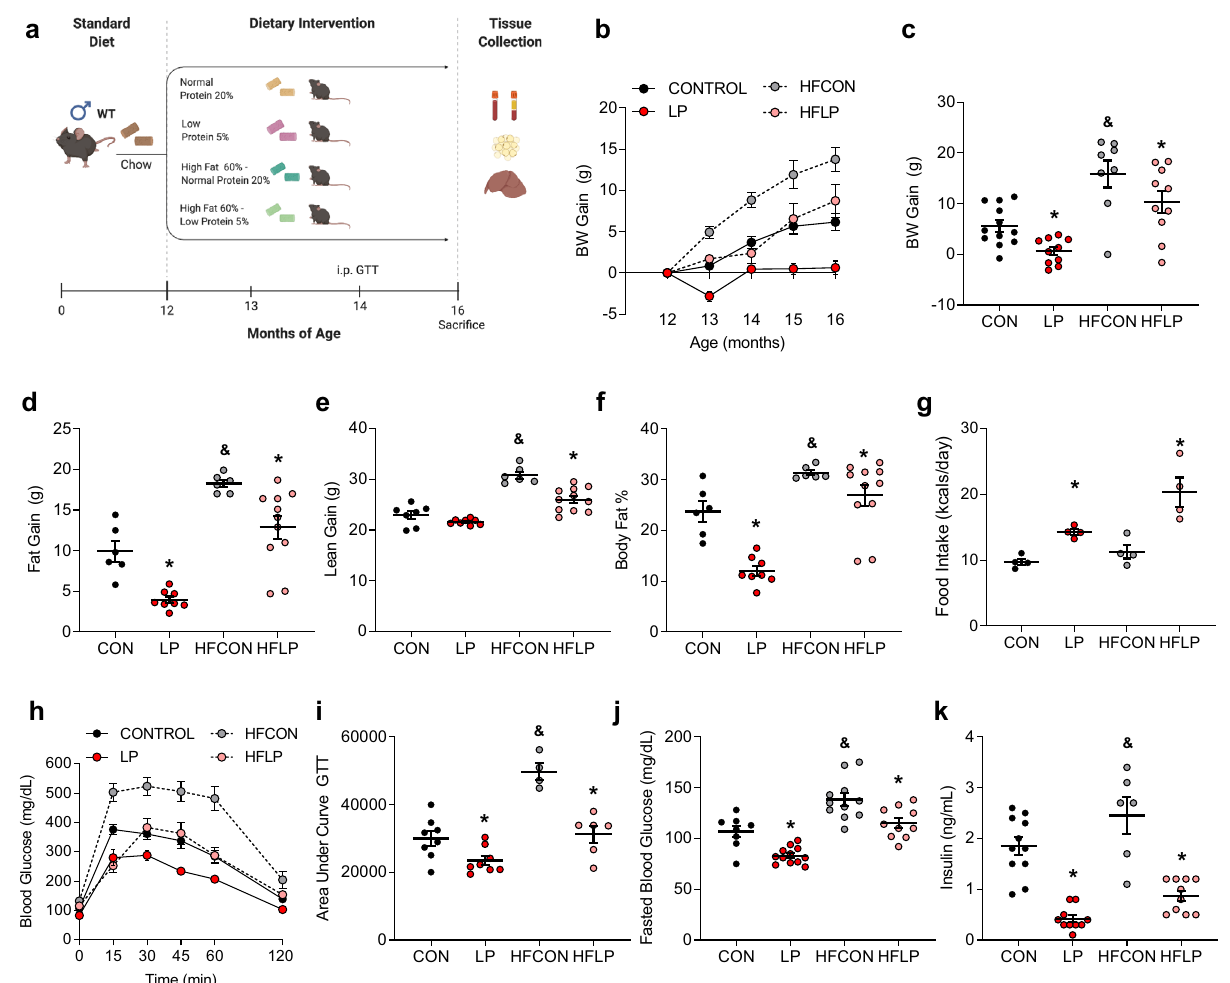
Fig. 7 Protein restriction promotes bene fi cial metabolic effects and protects against diet-induced obesity when initiated at middle age. a Schematic representation of middle-aged study. Wildtype and Fgf21 -KO mice were placed on CON, LP, HFCON, or HFLP diet at 12 months of age, with various metabolic endpoints assessed throughout the study as indicated and tissue collection at 16 months of age. b Body weight gain from initiation of diets ( n = 12 mice/group). c Body weight gain from diet initiation to sacri fi ce at 16 months of age ( n = 8 – 12 mice/group; fat p < 0.0001, protein p = 0.0046, fat*protein p = 0.8814). d Body fat gain from diet initiation to sacri fi ce at 16 months of age, as measured by NMR ( n = 6 – 12 mice/group; fat p < 0.0001, protein p < 0.0001, fat*protein p = 0.816). e Body lean gain from diet initiation to sacri fi ce at 16 months of age, as measured by NMR ( n = 6 – 12 mice/ group; fat p = 0.001, protein p = 0.001, fat*protein p = 0.0144. f Percent body fat at sacri fi ce at 16 months of age ( n = 6 – 12 mice/group; fat p < 0.0001, protein p < 0.0001, fat*protein p = 0.218). g Average daily food intake throughout the experiment ( n = 4 cages/group fat p = 0.6676, protein p = 0.0001, fat*protein p = 0.285). h Glucose tolerance test conducted at 14 months of age (2 months on diet ( n = 6 – 8 mice/group; group*time p = 0.001). i Area under the curve glucose for the GTT at 14 months of age ( n = 6 – 8 mice/group fat*protein p = 0.01). j Fasting blood glucose at 14 months of age ( n = 6 – 8 mice/group; fat p = 0.0001, protein p = 0.0001, fat*protein p = 0.94). k Serum insulin levels at sacri fi ce at 14 months of age ( n = 6 – 8 mice/group; fat p = 0.0033, protein p = 0.0001, fat*protein p = 0.4746). Statistical analyses were conducted using two-way ANOVA with dietary fat content and dietary protein content as main effects. All values are mean ± SEM, with signi fi cant main effects of protein or posthoc comparisons within the fat*protein interaction noted as * p < 0.05 vs respective control, and main effects of fat noted as & p < 0.05 HFCON vs CON. Source data are provided as a Source Data fi